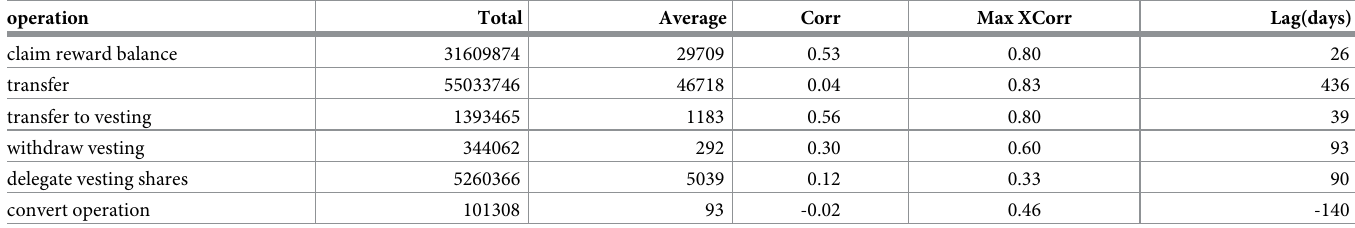
Table 3. Financial actions and cross-correlations with STEEM price. The column “Total” reports the overall volume of operations during the observation period. The second column reports the average daily volume. In the last three columns we report the cross-correlation, the maximum cross-correlation and the lag with the highest cross-correlation,